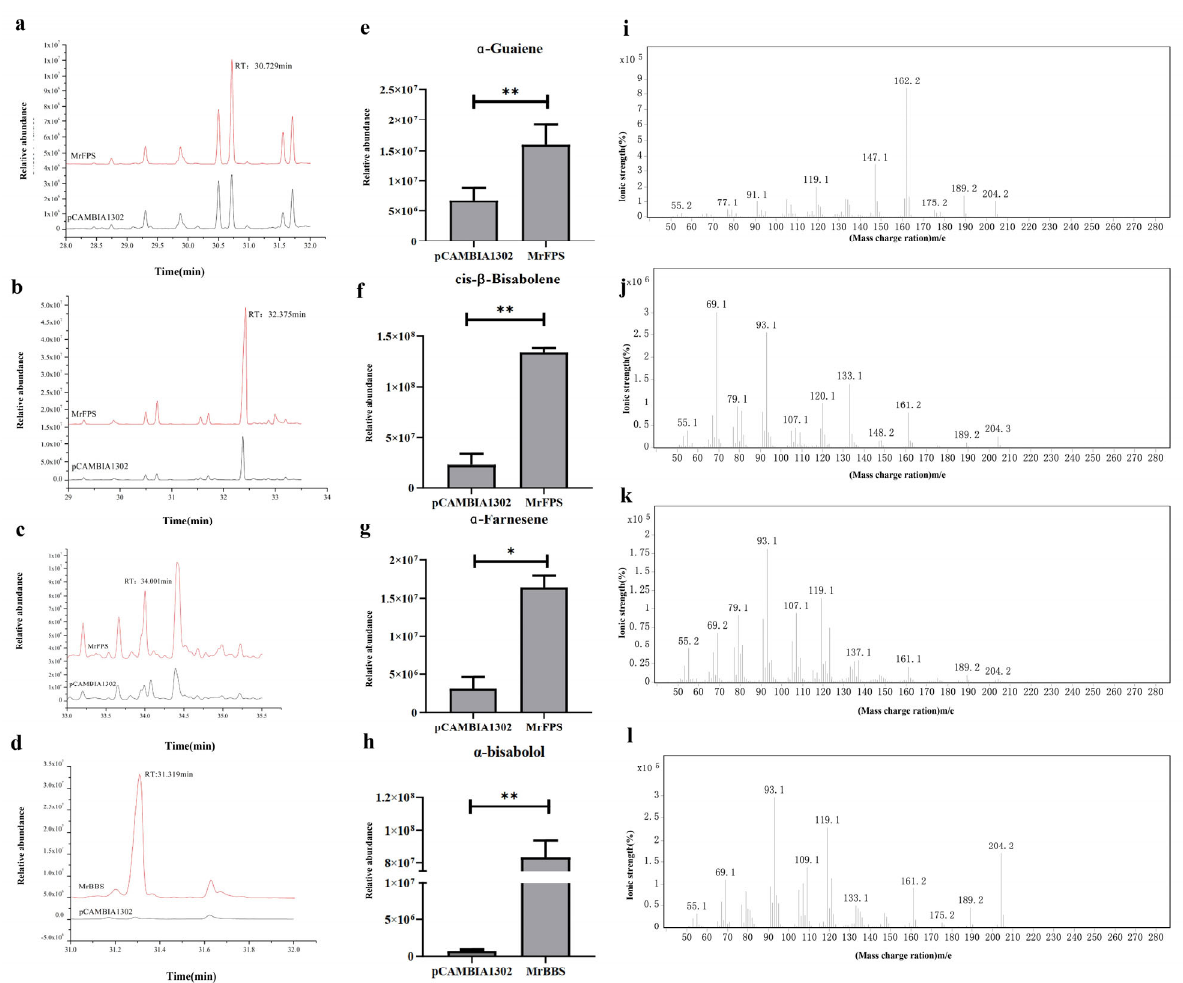
Figure 3. GC–MS analysis of overexpression of MrFPS ( a – c ) and MrBBS ( d ) in German chamomile hairy roots. Relative content analysis of α -guaiene, cis - α -bisabolene, α -farnesene, and α -bisabolol in overexpressing German chamomile hairy roots ( e – h ). ( i ) Mass spectrometry analysis of α -guaiene. ( j ) Mass spectrometry analysis of cis - α -bisabolene. ( k ) Mass spectrometry analysis of α -farnesene f. ( l ) Mass spectrometry analysis of α -bisabolol. Note: pCAMBIA1302 indicates hairy roots transformed with empty vector. Error bars are shown with three biological replicates ( t -test). One asterisk (*) indicates a significant difference (0.01 < p < 0.05) and ** indicate a very significant difference ( p <